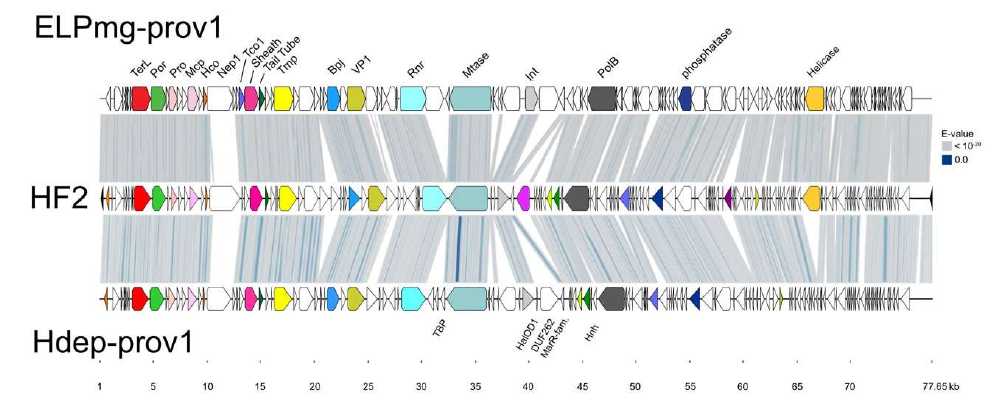
Figure 5. Comparison of HF2 and the provirus elements Hdep-prov1 of Hrr. depositum Y78 (located between FGM06_RS03355 to FGM06_RS03870) and ELPmg-prov1 (from scaffold ID JGI12451J12833_1000001; NCBI project accession PRJNA366386). Scale is shown underneath, in kb. The tBLASTx similarity between the genomes is indicated by the grey-to-blue shading (key upper right). A number of gene products are indicated above the ELPmg-prov1 map (see Figure 4 for details). Additional genes are indicated below the Hdep-prov1 map as follows; TBP, transcription factor B protein; HalDo1, Halobacterial output domain 1 containing protein; DUF262, domain of unknown function (DUF) 262 containing protein; MarR-fam., MarR family transcription factor; Hnh, HNH